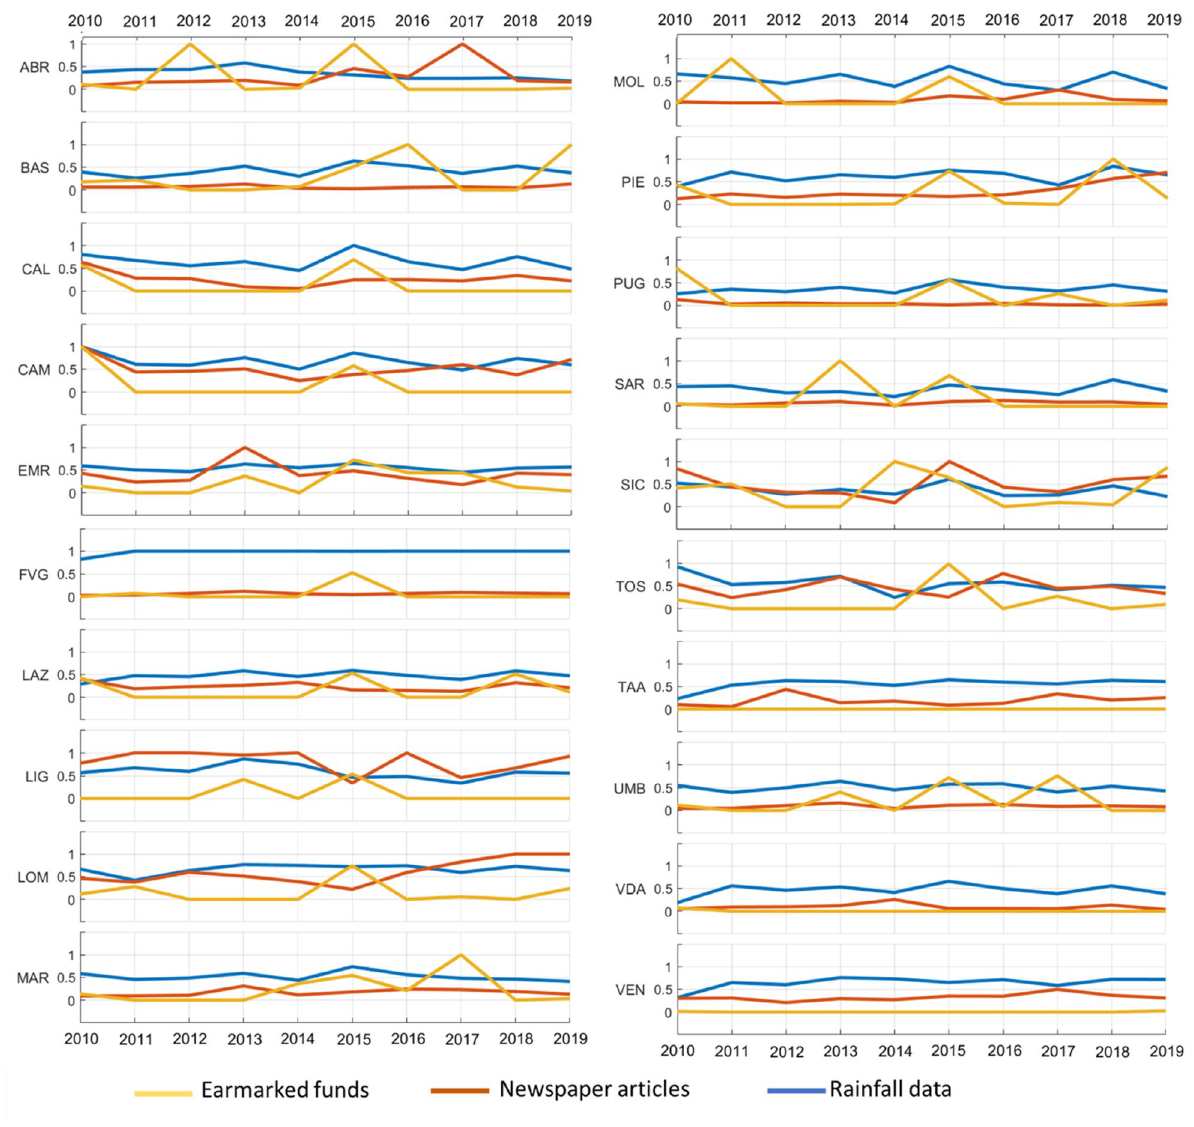
Figure 6. “Newspaper articles”, rainfall distribution and earmarked funds were normalized and correlated for each region for 10 years. ABR Abruzzo, BAS Basilicata, CAL Calabria, CAM Campania, EMR Emilia-Romagna, FVG Friuli-Venezia Giulia, LAZ Lazio, LIG Liguria, LOM Lombardy, MAR Marche, MOL Molise, PIE Piedmont, PUG Puglia, SAR Sardinia, SIC Sicily, TOS Tuscany, TAA Trentino-Alto Adige, UMB Umbria, VDA Valle d’Aosta, and VEN